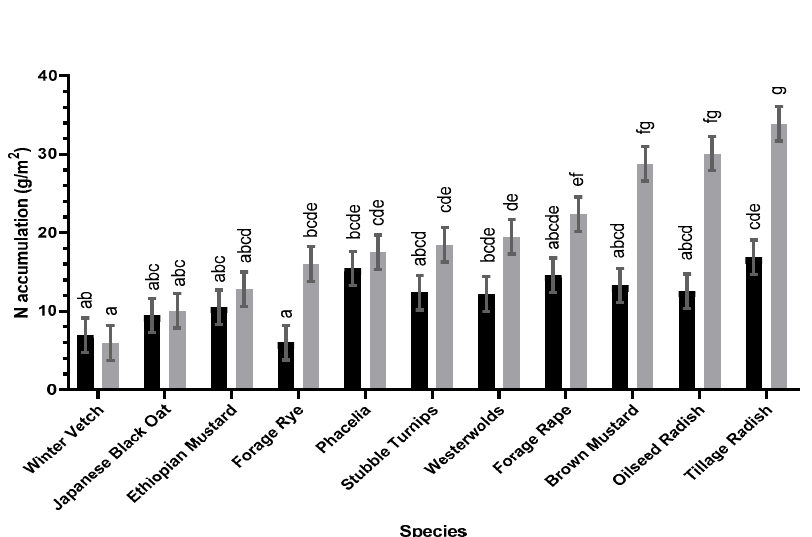
Figure 1. Species N accumulation in response to slurry (g / m 2 ). The bars represent the species mean for both treatments of slurry (N = 4). Error bars represent Standard Error (SE). Letters represent significant di ff erences between cover crops using Fisher’s post-hoc test 0.05 LSD = 3.69. Means that do not share the same letters are significantly ( p < 0.05) di ff erent. Slurry supplied 33.0 g / m 2 of total N.